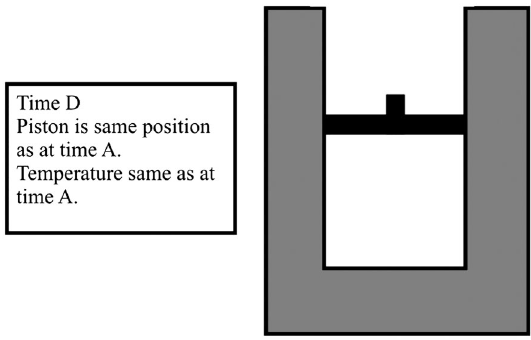
FIG. 7. The ideal gas system at time